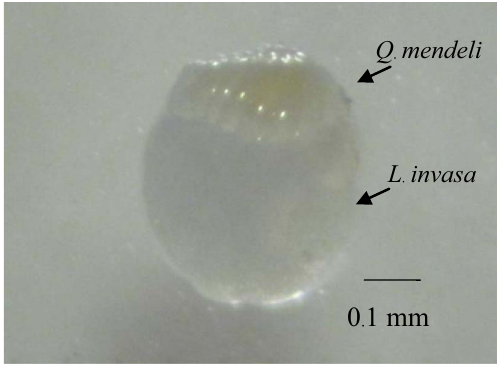
Figure 5. Larva of Quadrastichus mendeli developing on that of Leptocybe invasa.